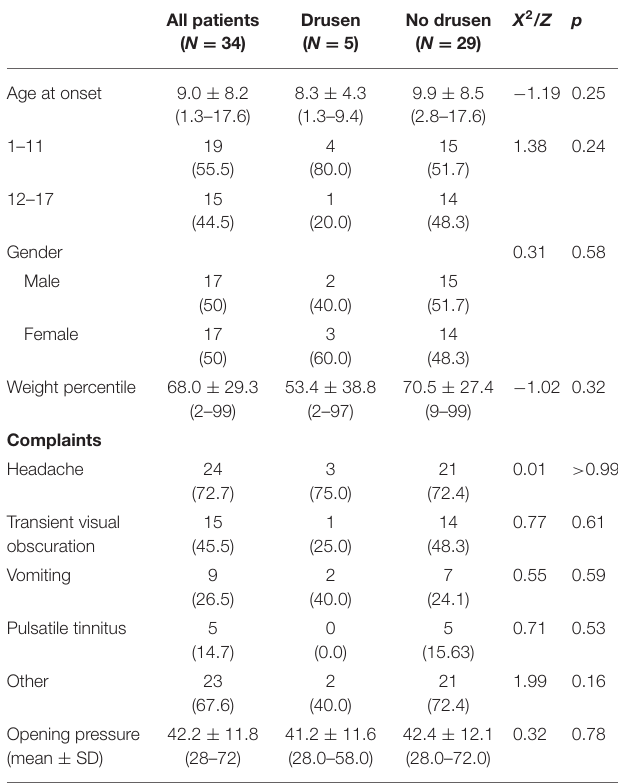
TABLE 2 | Demographic and clinical characteristics of patients with PTCS, with and without optic nerve drusen. All patients ( N =